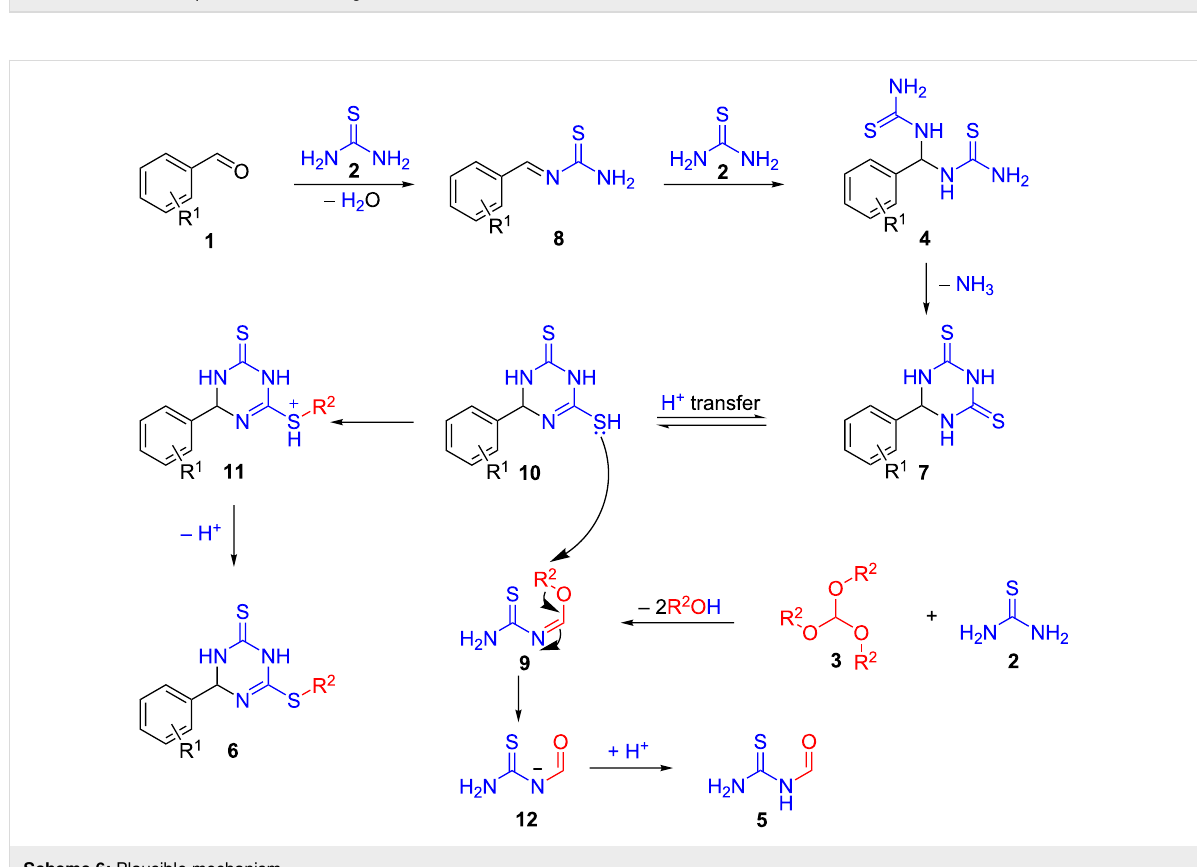
Scheme 6: Plausible